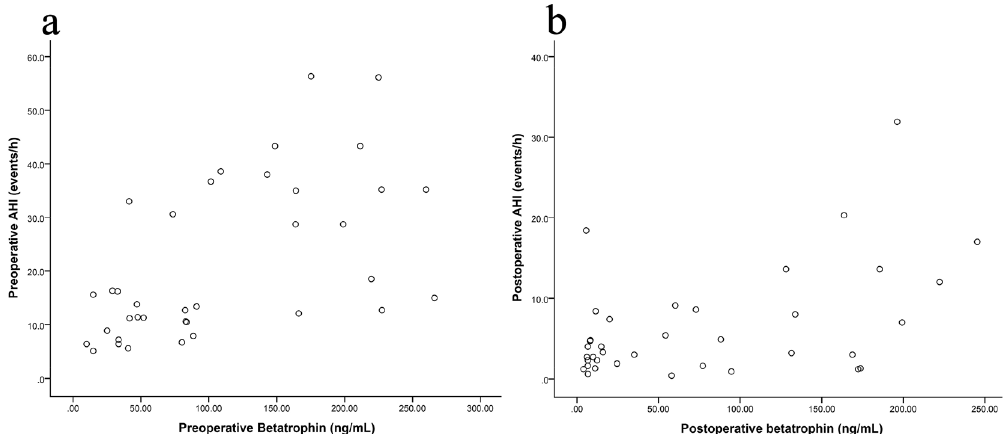
Figure 2. ( a ) A Bland–Altman plot of the preoperative AHI versus the preoperative betatrophin. ( b ) A Bland– Altman plot of the postoperative AHI versus the postoperative betatrophin. AHI apnea hypopnea index.